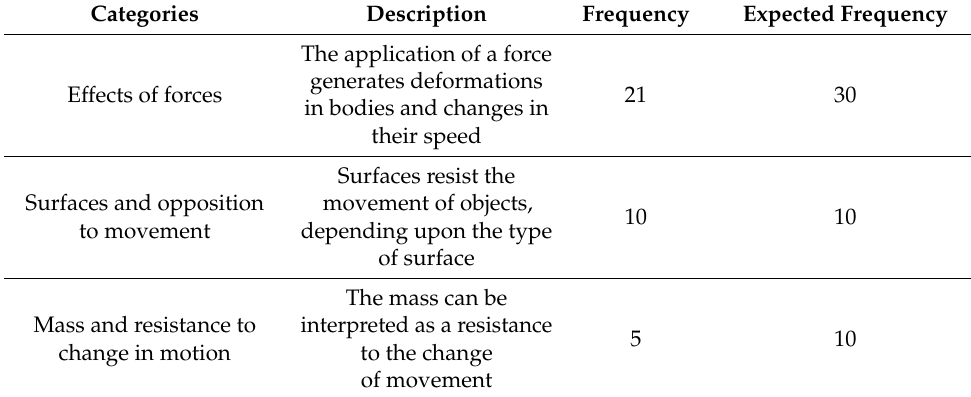
Table 3. Categories of analysis focal group